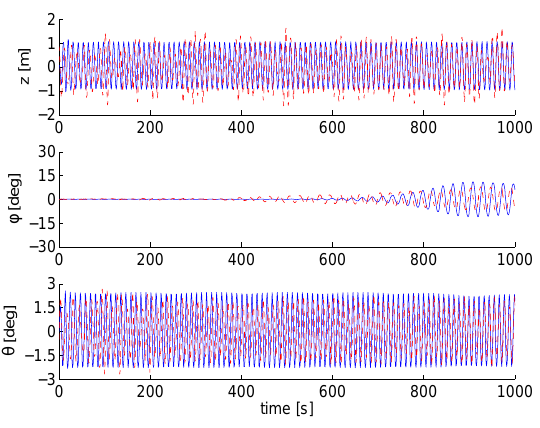
Figure 14: Exp. 1186. Exp. dashed red, sim. solid blue.